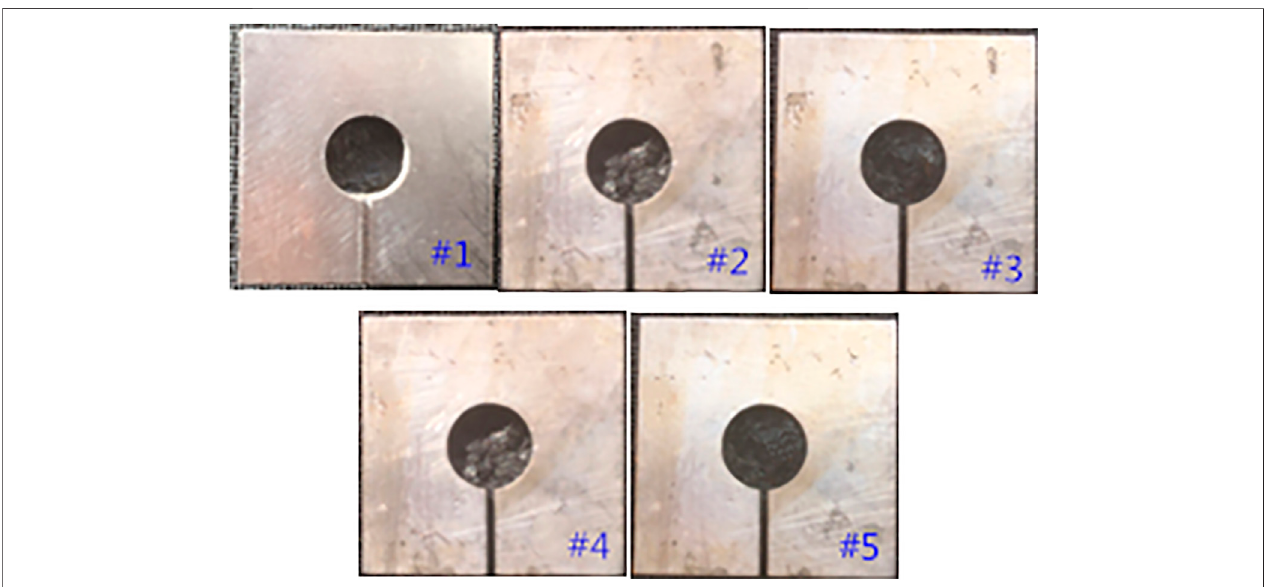
FIGURE 1 | Coal slices processed for SAXS